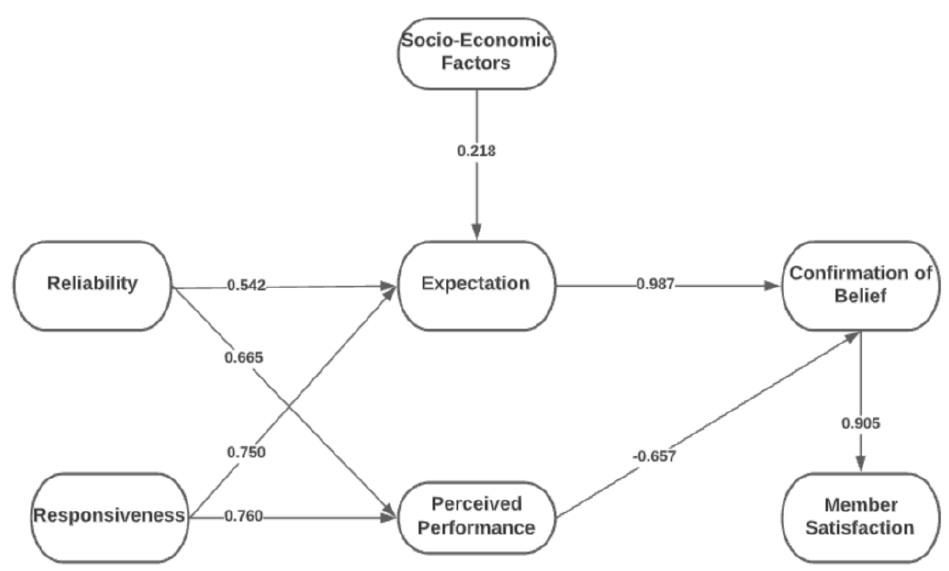
Figure 5. Final SEM Model of determining the Members’ Satisfaction towards